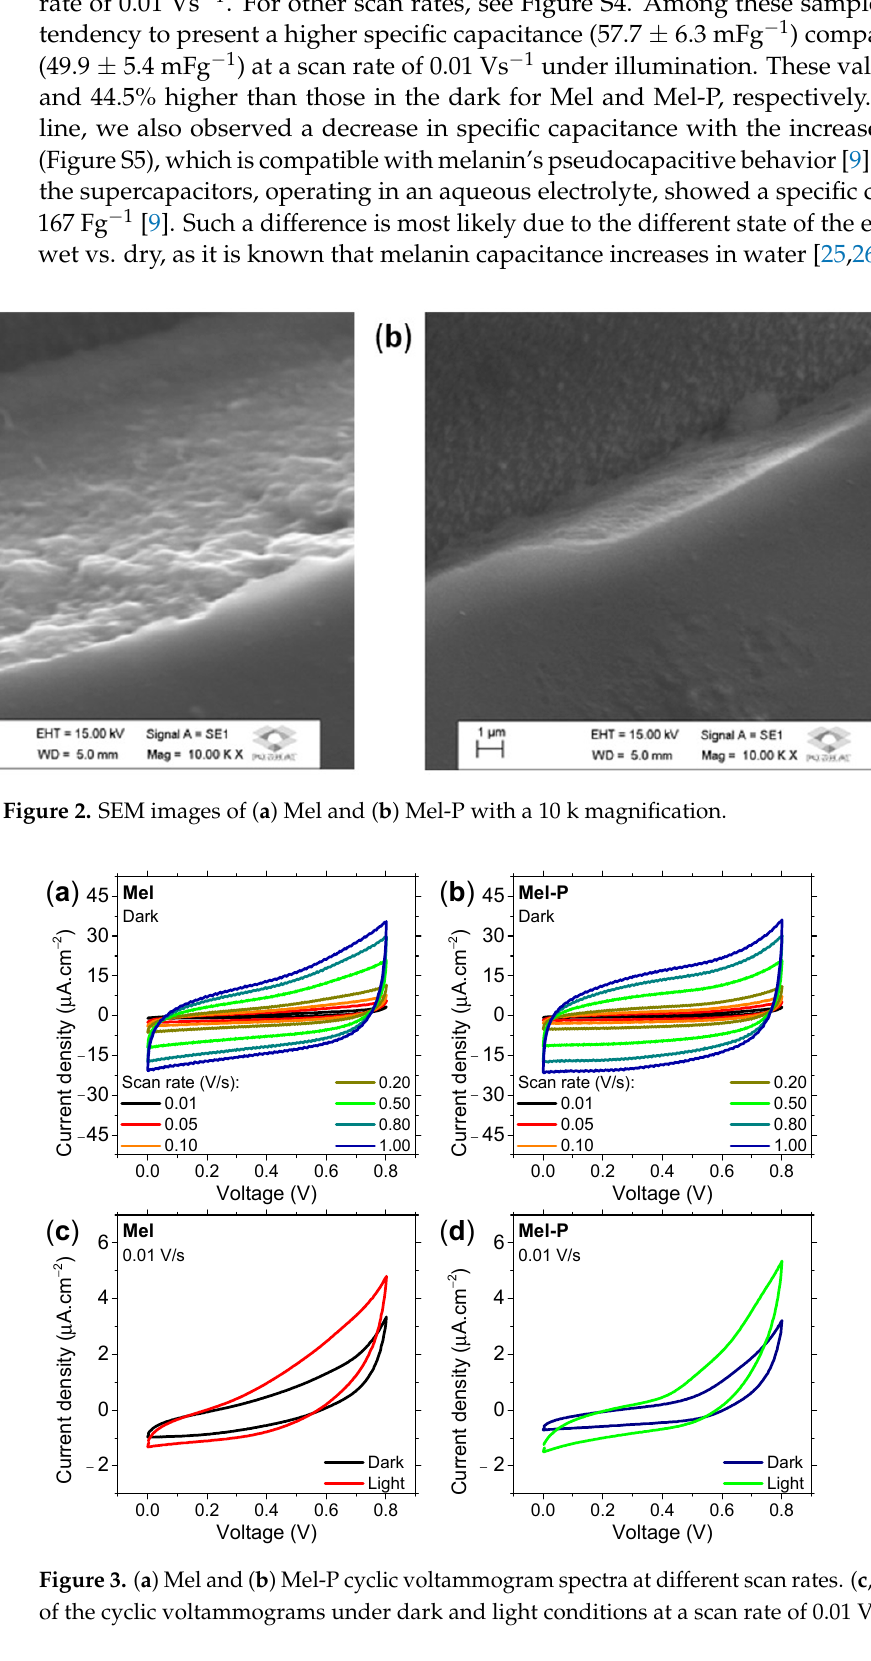
Figure 2. SEM images of ( a ) Mel and ( b ) Mel-P with a 10 k magnification.